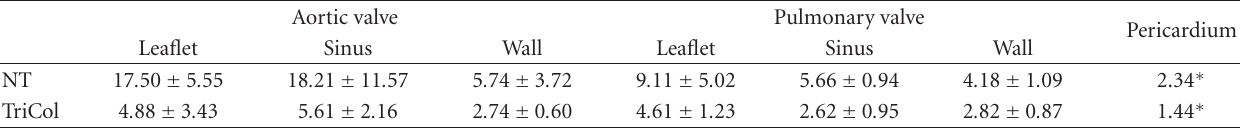
Table 1: Total GAG content ( μ g hexuronate/mg DDT) in the selected areas of cardiac valves and in pericardial tissue (before and after TriCol treatment).